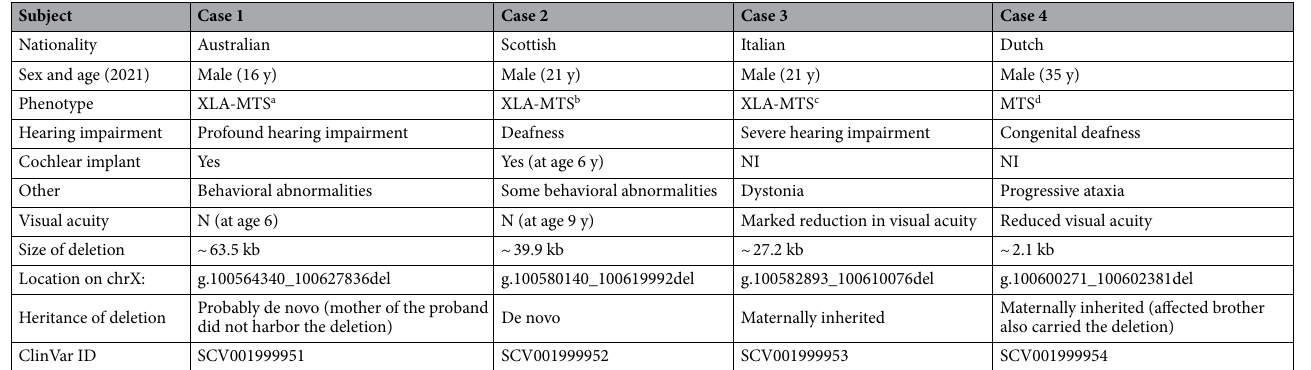
Table 1. Clinical and molecular features of the four MTS cases identified. a Briefly mentioned in Tranebjærg, 2013, as patient 33; b Briefly mentioned in Tranebjærg, 2013, as patient 34; c Clinical details published in Pizzuti et al. 2004, d Briefly mentioned in Tranebjærg, 2013, as patient 35. NI = no information; N = normal; y =